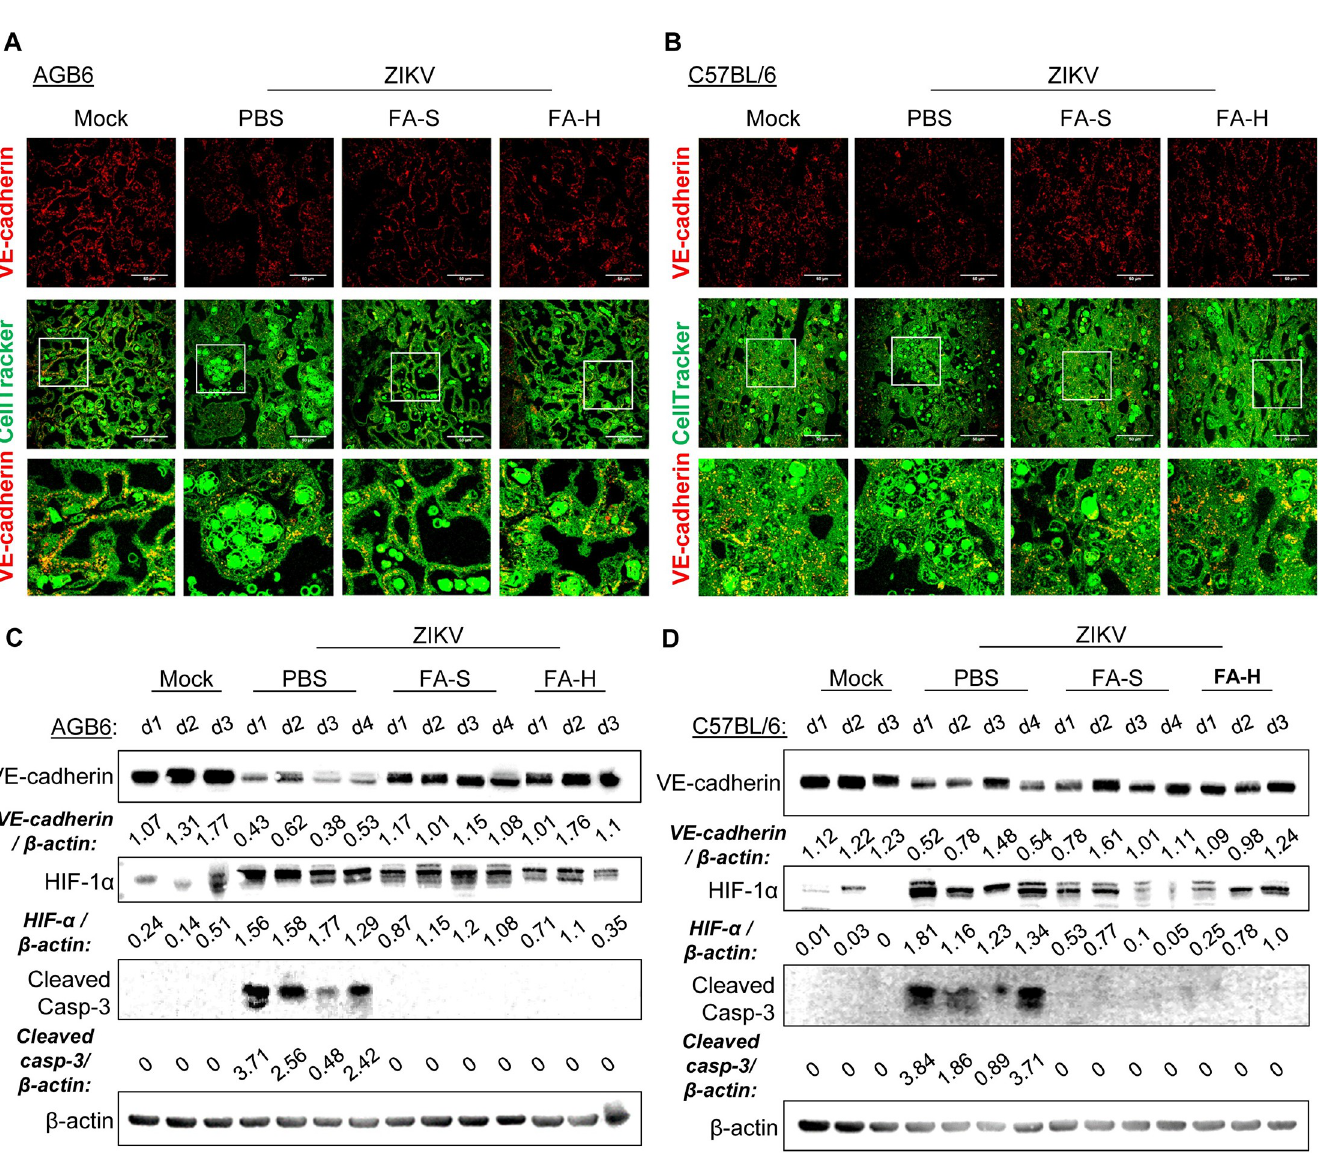
Fig 7. FA improves the prognostic profile of placental dysfunction. (A-B) Representative confocal images of placental sections of AGB6 mice (A) and IFNAR1 antibody-treated C57BL/6 (B) Placenta immunostained for VE-cadherin (red) and CellTracker for cytoplasm (green). (C-D) Western blot analysis of protein level of VE-cadherin, HIF-1 α , cleaved caspase-3, and β -actin for loading control of placental AGB6 (C) and IFNAR1 antibody-treated C57BL/6 (D) mice. Samples are pooled placental tissue lysates of 3–4 representative pregnant mice (d1-d4).